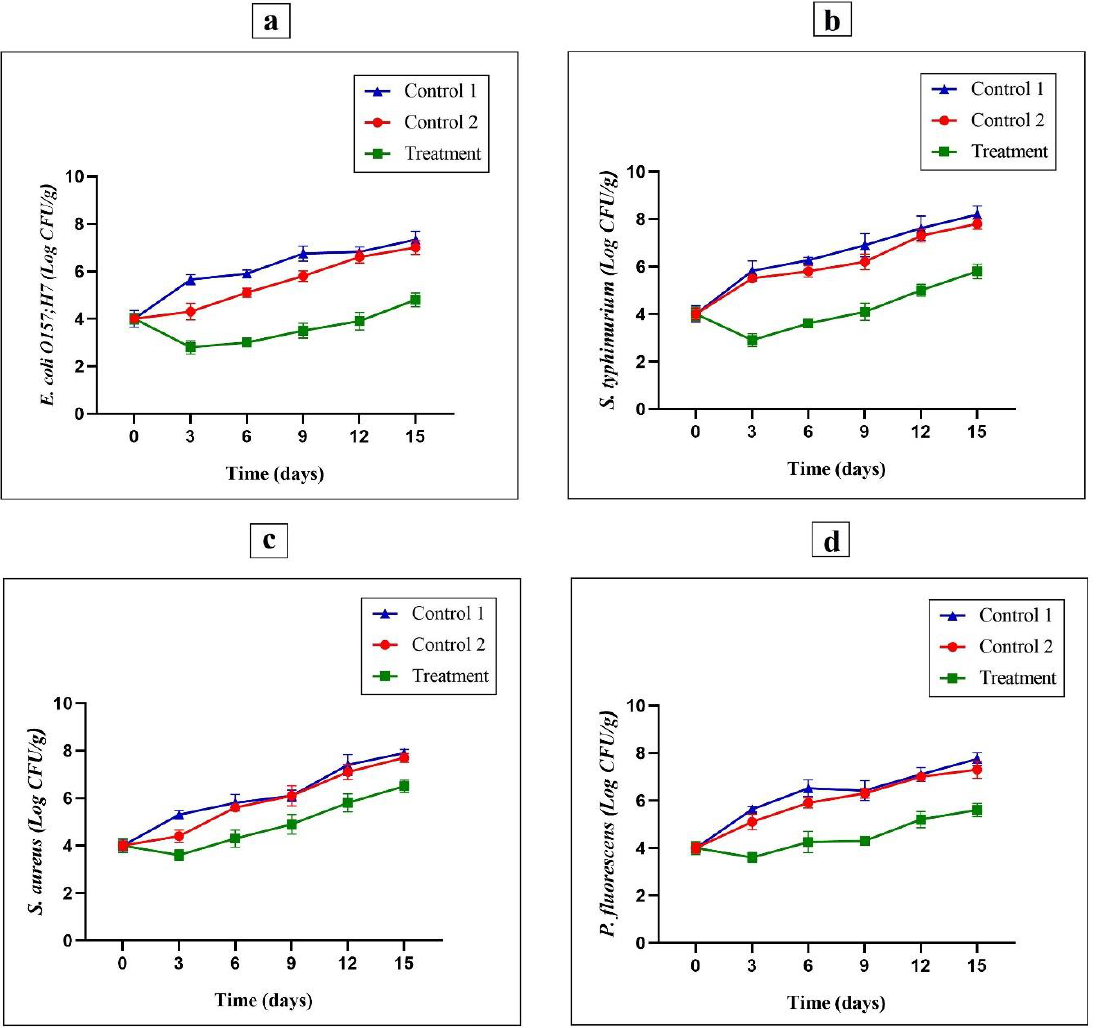
Figure 5. The antimicrobial effects of G/PVA/MEO/CWE films (as treatment), PE films (Control 1) and G/PVA films (Control 2) against E. coli ( a ), S. typhimurium ( b ), S. aureus ( c ) and P. fluorescens ( d ) in the inoculated raw turkey breast meat during 15 days of the storage in refrigeration at 4 ◦